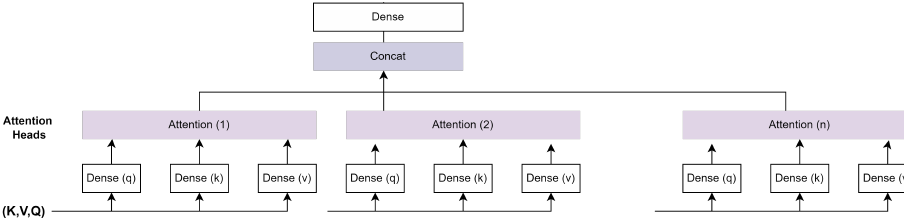
Figure 3. Multi-head attention